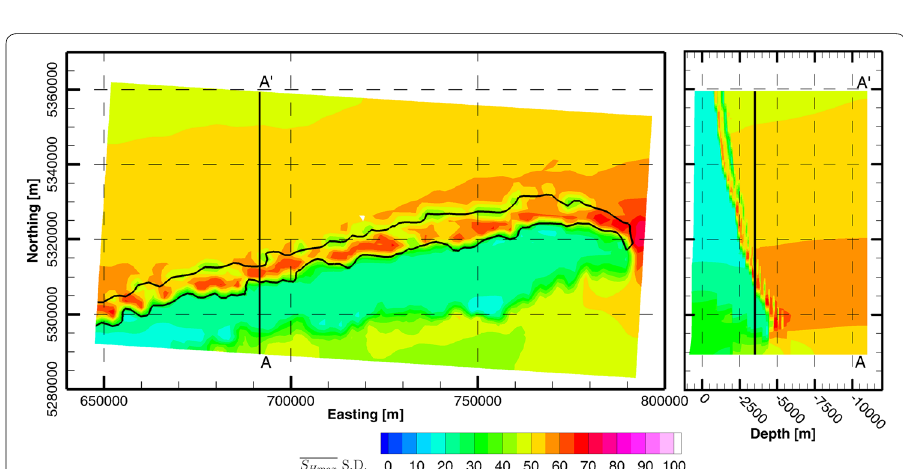
Fig. 6 The standard deviation of S Hmax derived from the model results on a horizontal plane in a depth of 3500 m below sealevel (left) and on the profile A – A ′ (right) with a vertical exaggeration of 1:4. In map‑view, the intersection of the southward dipping Malm units with the horizontal plane is outlined by the solid black line. North of the intersection is basement rock, south of the intersection is sedimentary Molasse units. In the profile, the depth of 3500 m is indicated by a bold black −